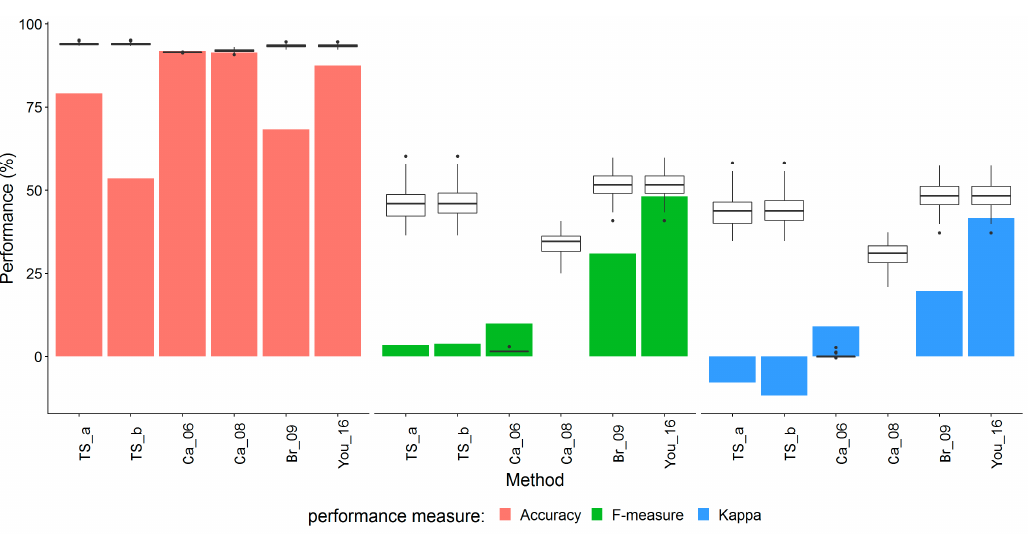
Figure 3. Performance of the classification methods from the literature (columns) using different performance indicators. The box plots represent the performance of a linear discriminant model (LDA) using the same parameters suggested by each model and a cross validation with 200 repetitions of stratified sampling.